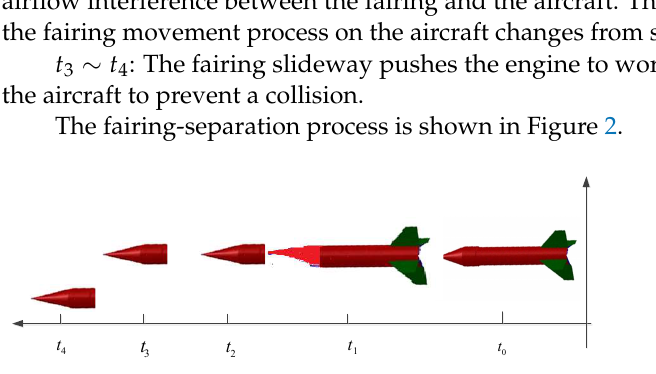
Figure 2. Schematic diagram of the fairing-separation process.